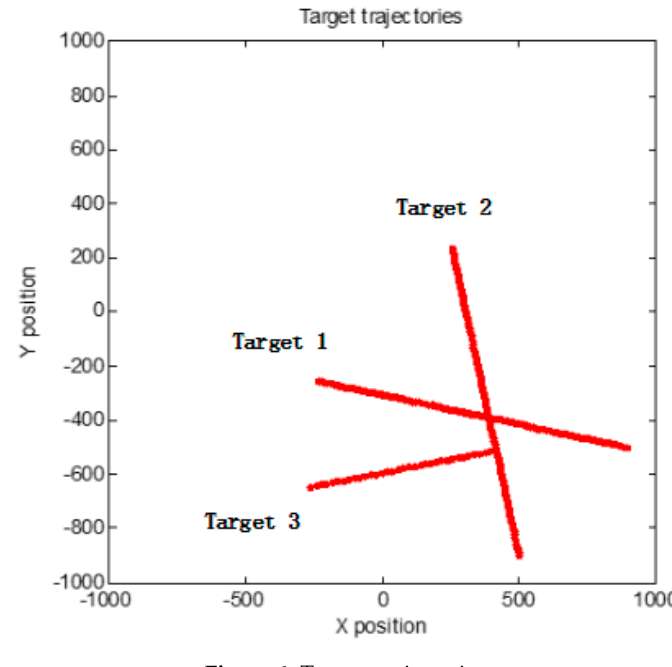
Figure 6. Targets trajectories.